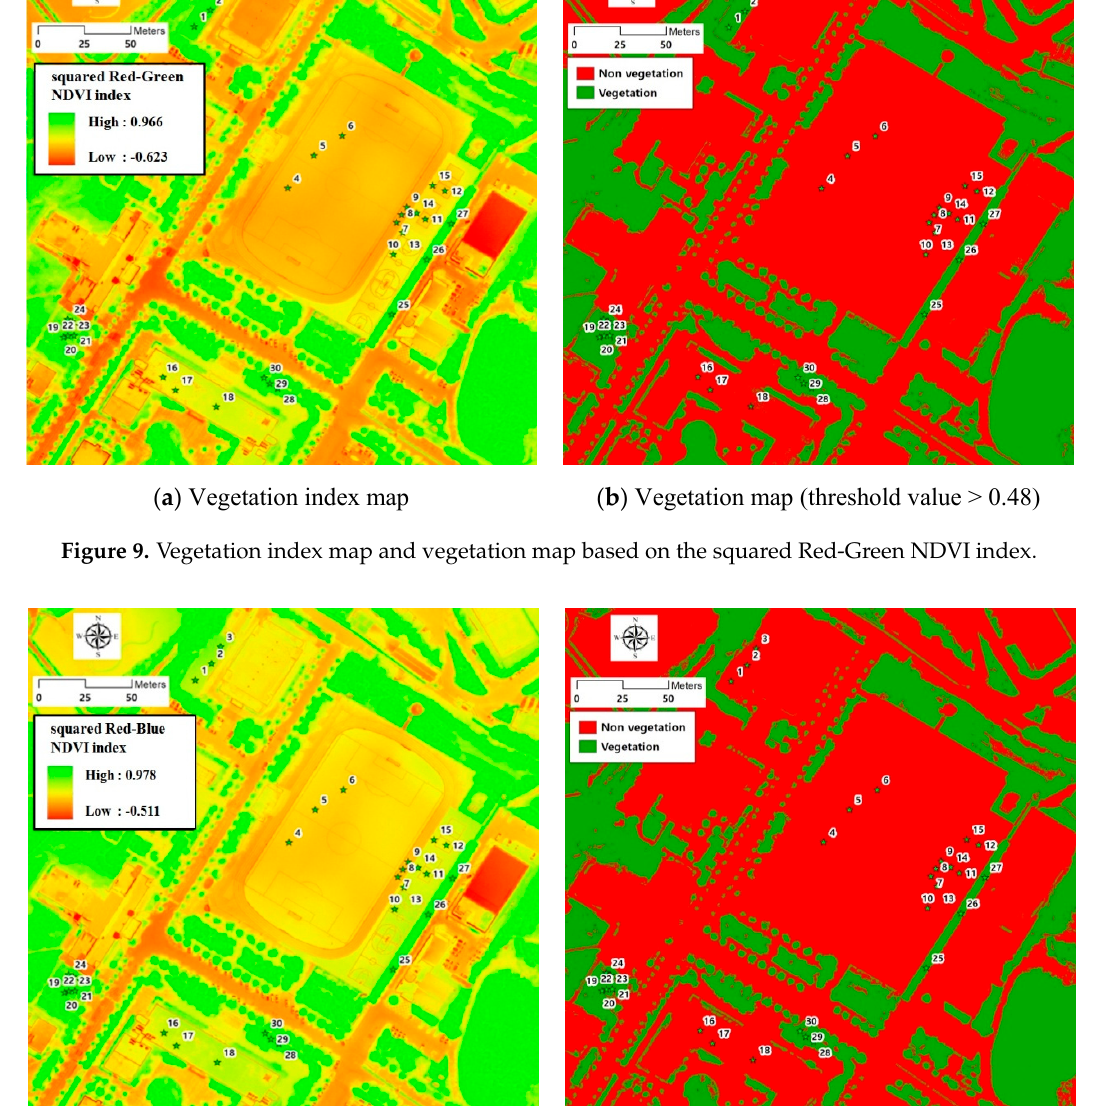
Figure 8. Vegetation index map and vegetation map based on the squared Blue-Green Normalized Difference Vegeta- tion Index (NDVI) index.